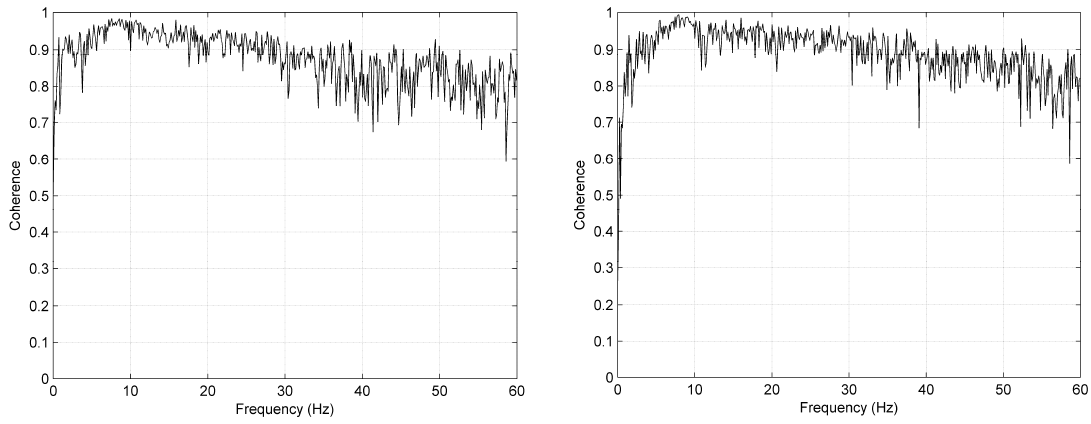
Figure 8. Coherence spectra for channel P3, no filtering except detrending. Left: Type I with NaCl, right: Type II with NaCl. The figures show the mean coherence over four subjects.